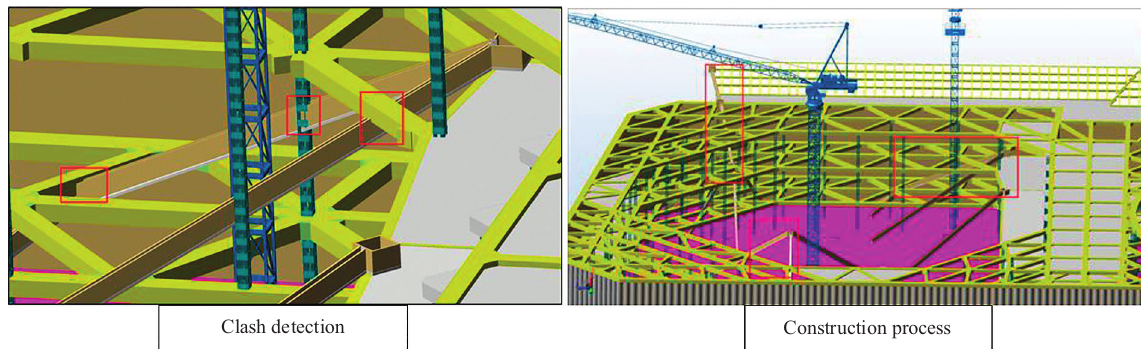
Figure 14: Clash detection and construction process modeling in 3D